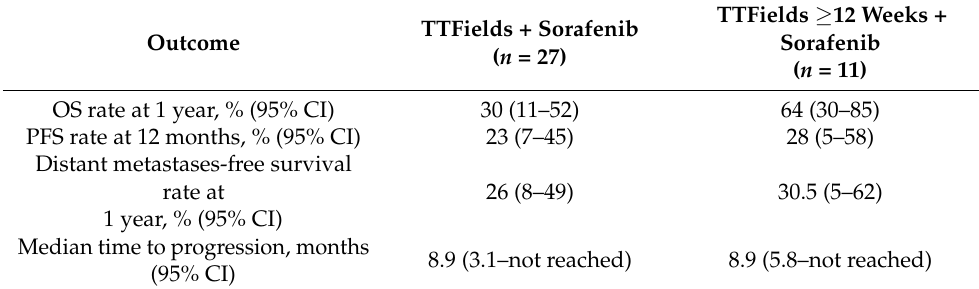
Table 3. Time to event outcomes with TTFields (150 kHz) concomitant with sorafenib.